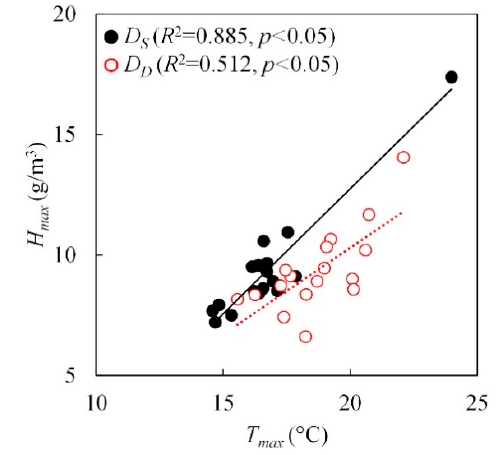
Figure A1. Relationship between maximum humidity and maximum temperature.